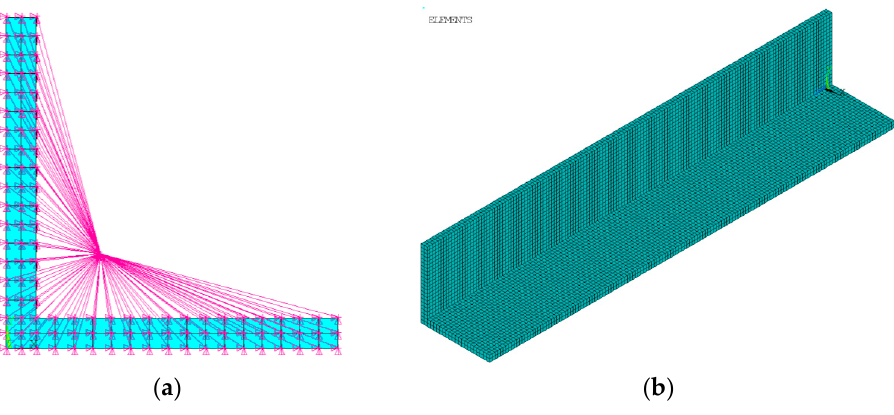
Figure 9. FE model: ( a ) rigid domain; ( b ) the meshed FE model.